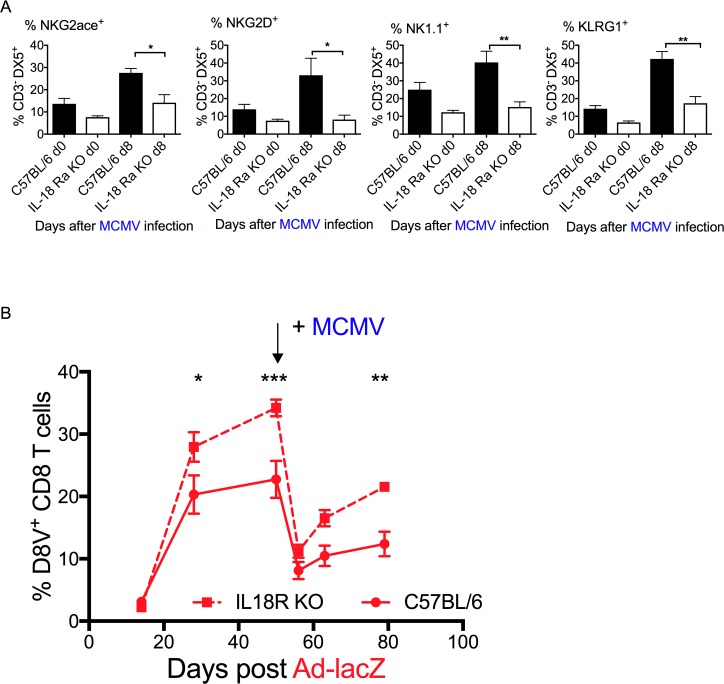
Effect of MCMV infection on pre-existing D8V responses in Ad-lacZ- immune IL-18KO mice.(A) NK cell activity in IL-18 mice upon MCMV infection. The levels of activation markers NKG2ace, NKG2D, NK1.1 and KLRG1 (left to right) were measured by ex vivo staining of blood after MCMV infection (N = 8–12 mice per group from 2 independent experiments). (B) IL-18RKO mice were immunized with Ad-lacZ, then 50 days later were infected with MCMV (as indicated). The levels of pre-existing D8V+ CD8 T cells in the blood of IL-18R KO mice (N = 5 per group) were measured by ex vivo tetramer staining. p values were determined using one-way Anova. *p<0.05, **p<0.005, ***p<0.0005.